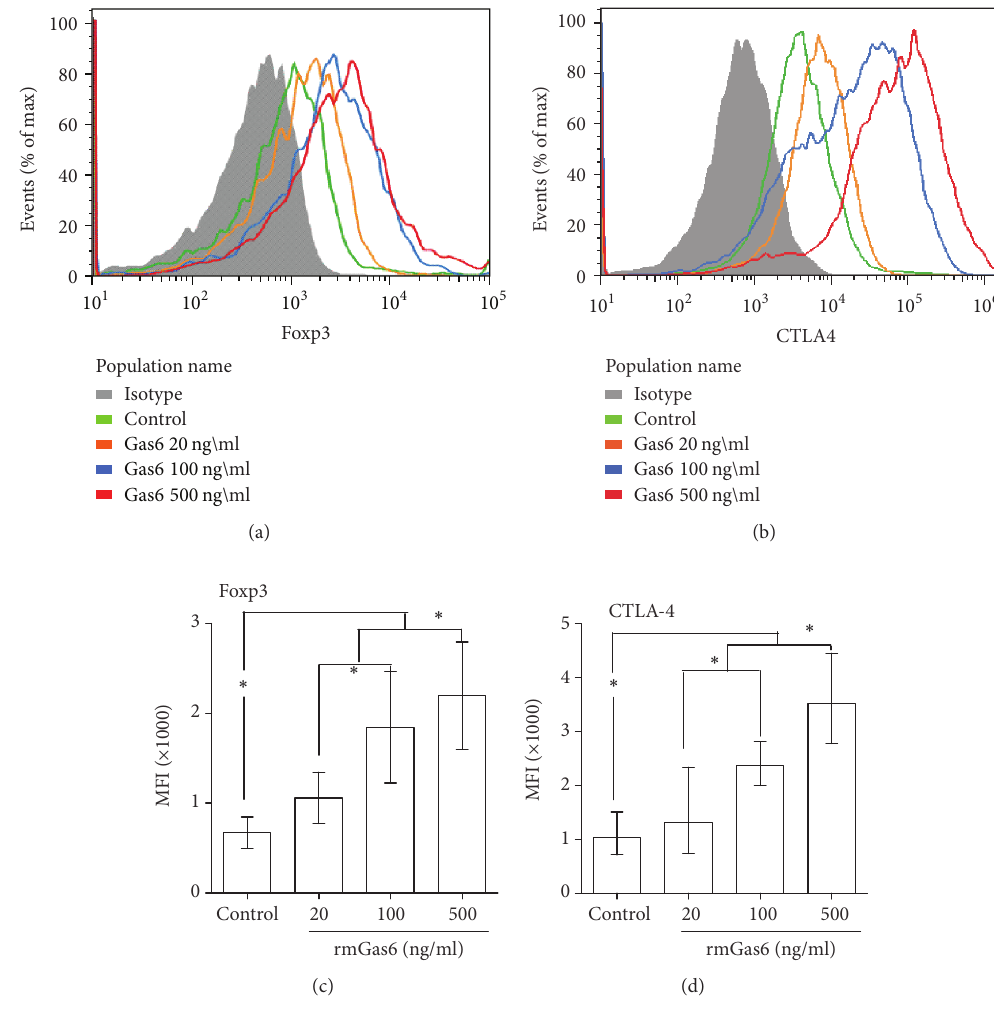
Figure 4: Effects of Gas6 on Foxp3 and CTLA-4 expression in CD4 + CD25 + Tregs in vitro. Representative examples of Foxp3 (a) and CTLA- 4 (b) expressions in CD4 + CD25 + Tregs after 20, 100, and 500 ng/ml rmGas6 stimulation for 24 hours. The average levels of Foxp3 (c) and CTLA-4 (d) were increased after Gas6 stimulation ( 𝑛 = 4 /group). ∗ 𝑃 < 0.05